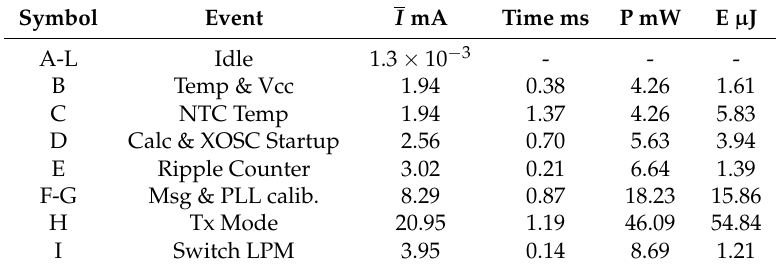
Figure 11. Measured power consumption of the prototype node during a sense and send event. Table 1. Power consumption of the eZ430-RF2500 board during a sense-and-send event.